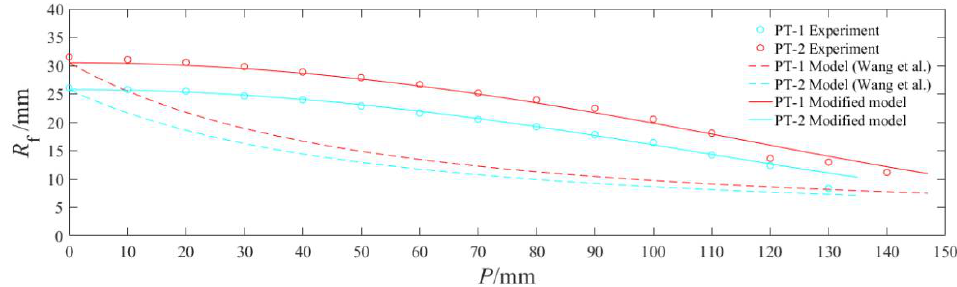
Figure 7. Comparison of the experimental data with the model in [18] and the modified